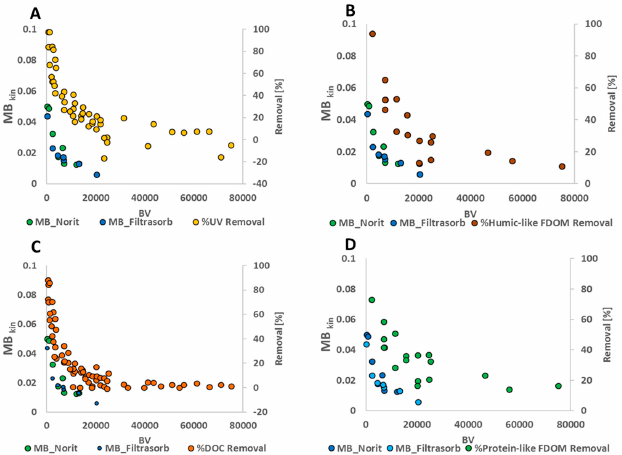
Figure 6. Change in methylene blue (MB) kinetic sorption factor as a function of the number of bed volumes (BV) for the granulated activated carbon types Filtrasorb 400 (light blue, columns C3-F18, C4-F6) and Norit 830W (dark blue, column C1-N18) compared with removal of ( A ) UV (light orange), ( B ) humic-like fluorescent dissolved organic matter (FDOM) (dark brown), ( C ) dissolved organic carbon (dark orange), and ( D ) protein-like FDOM (green). Percentage change for all columns ( n = 4).